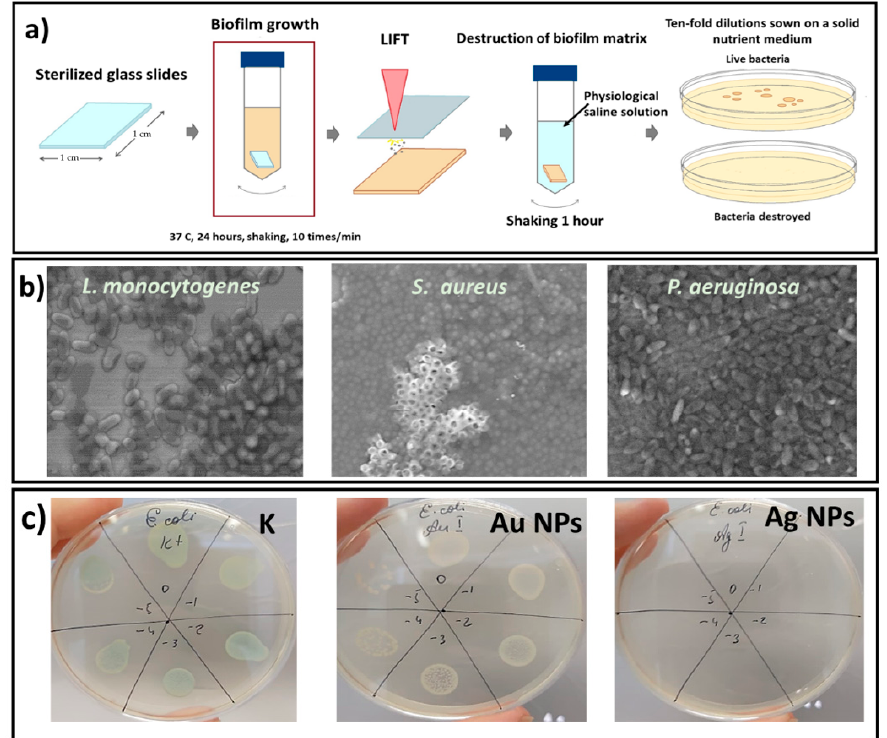
Figure 5. Scheme of the antibacterial investigations ( a ). SEM visualization of the bacterial biofilms ( b ). Antibacterial effect of gold and silver nanoparticles on the biofilm of E. coli ( c ). K is the control sample with the bacterial biofilm not treated with